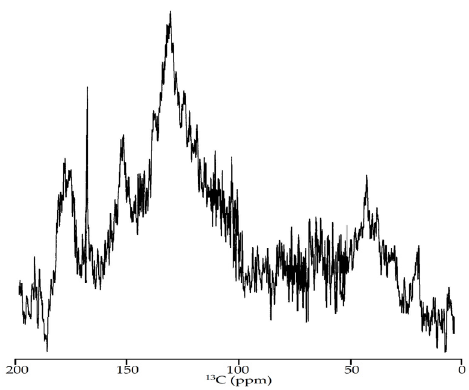
Figure 7. The NMR 13 С spectrum of E. angustifolium melanoidin (EAM).